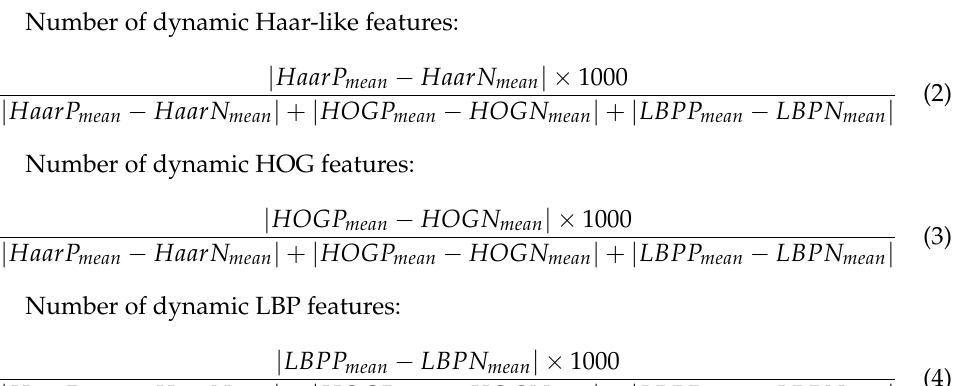
Figure 8. Feature extraction process of LBP.